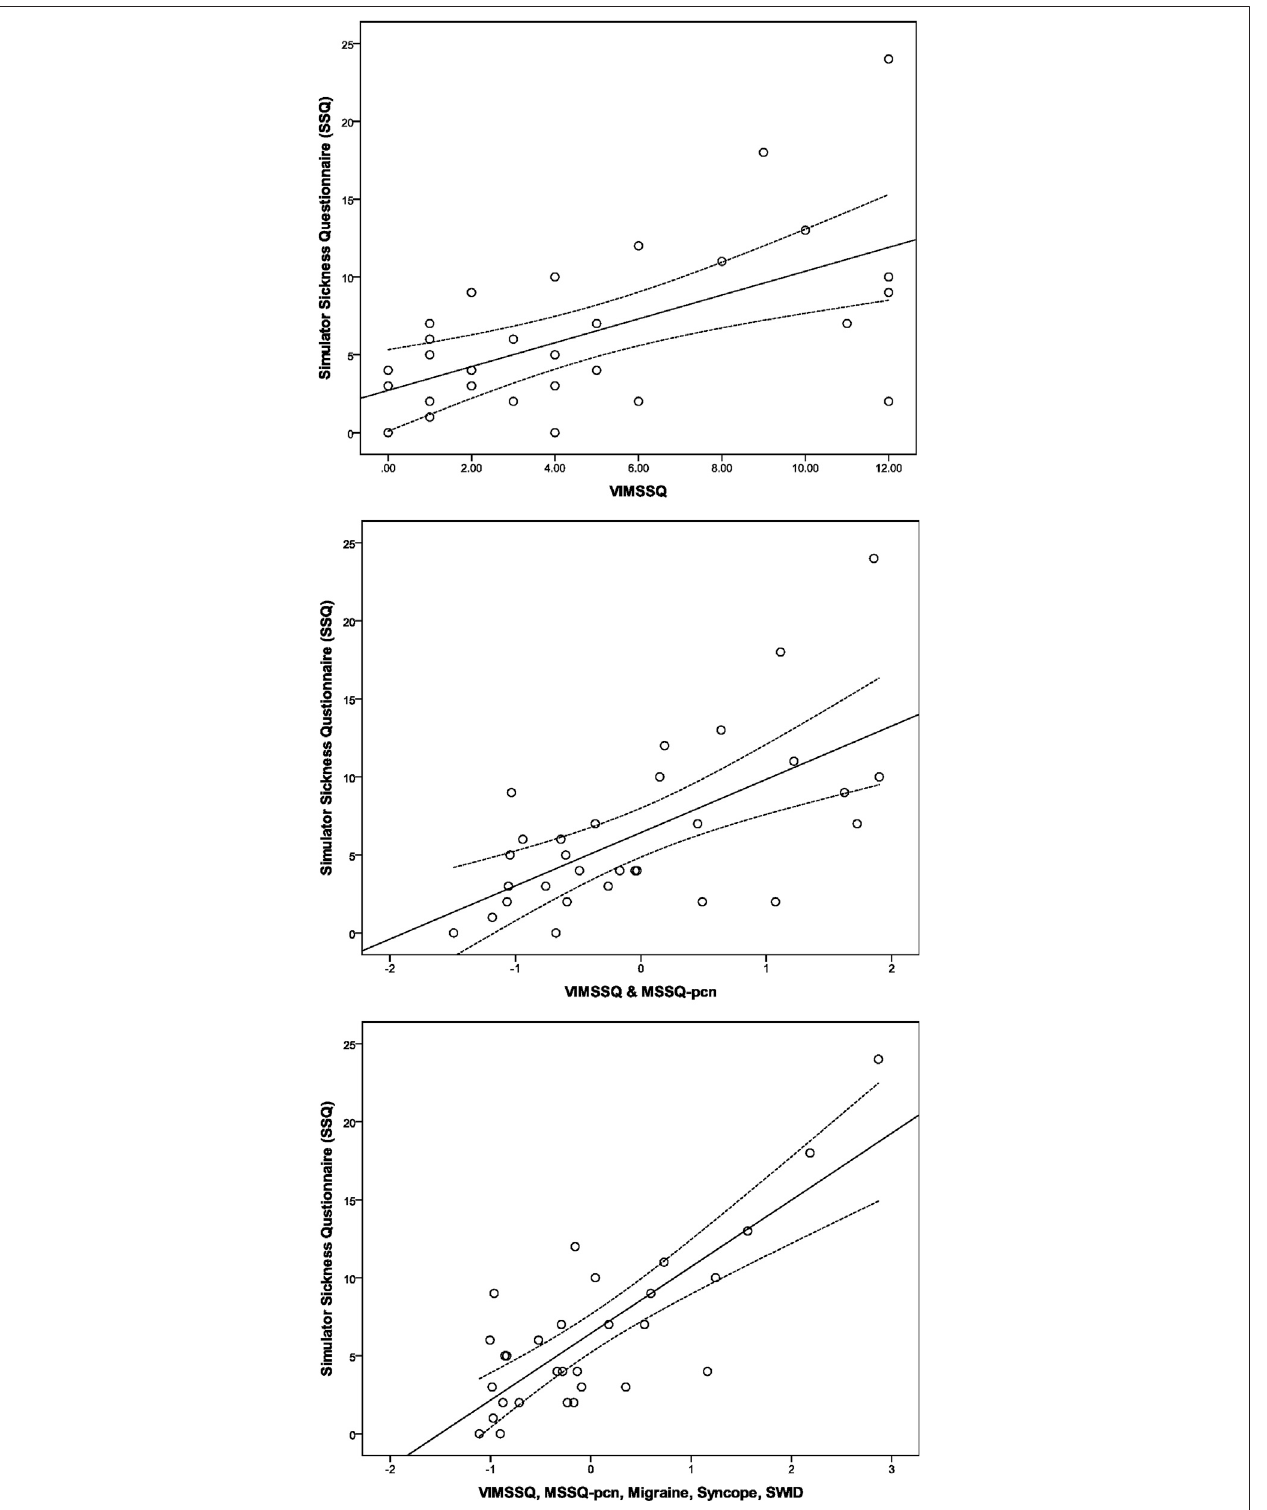
FIGURE 2 | Prediction of visually induced motion sickness (VIMS) as measured by the SSQ, showing how prediction ef fi ciency increases as more predictor variables are added to the multiple linear regression models. Top using as predictor: VIMSSQ only (R 2 (cid:2) 0.34); middle using: VIMSSQ and MSSQ percentile (pcn) (adjusted R 2 (cid:2) 0.36); bottom using: VIMSSQ, MSSQ percentile (pcn), migraine, syncope, and SWID (adjusted R 2 (cid:2) 0.56). The fi tted regression line is shown in each scatterplot together with the 95%CI dashed lines on either side.